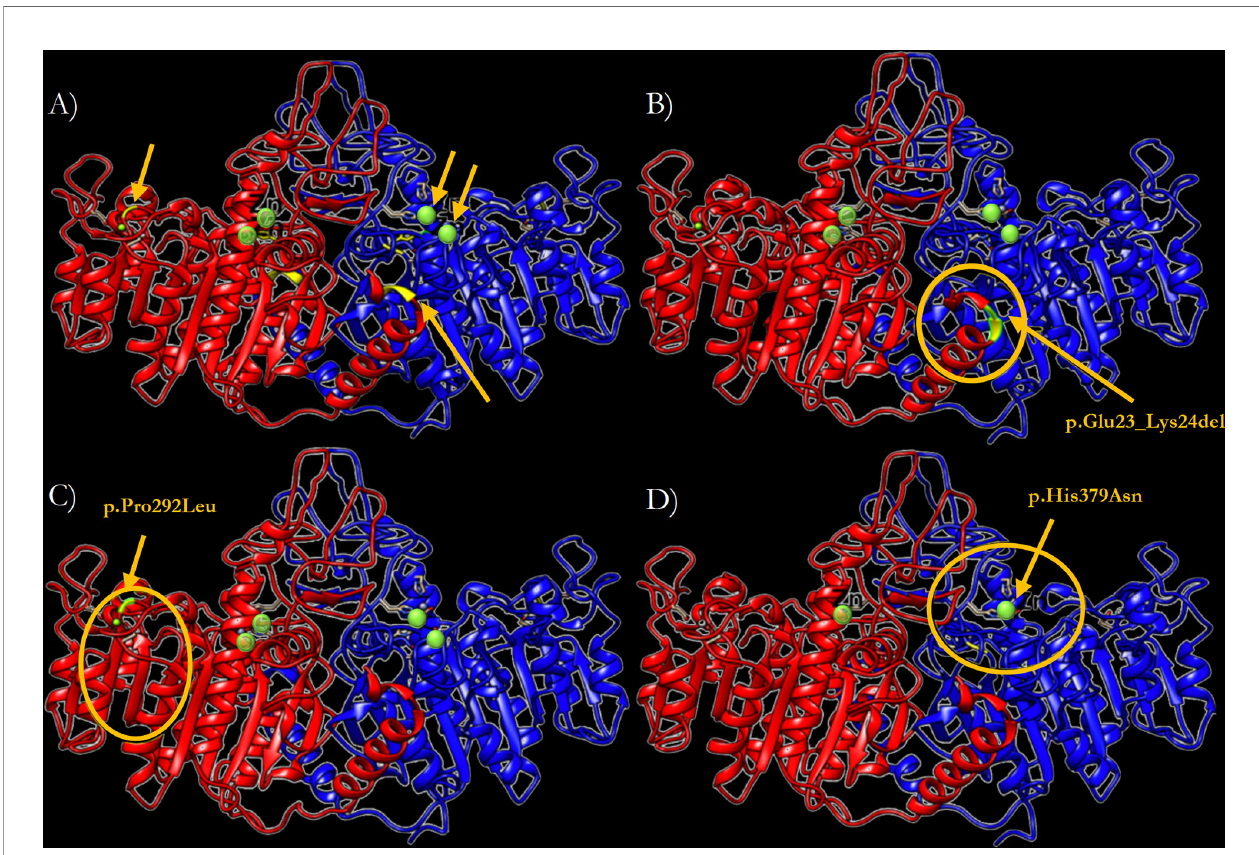
FIGURE 5 | Three-dimensional representation of the TNSALP protein in the form of ribbons. (A) TNSALP WT. Zn 2+ atoms bound to the corresponding Zn 2+ binding sites are highlighted in green. The arrows indicate the location of the different mutations identi fi ed in this study. (B) TNSALP with the genetic variant p.Del Glu23_Lys24. The deletion is marked in yellow and the major structural changes are highlighted with a yellow circle. (C) TNSALP with the genetic variant p.Pro292Leu. The amino acid substitution is marked in yellow and the major structural changes are highlighted with a yellow circle. (D) TNSALP with the genetic variant p.His379Asn. The loss of 2 of the 4 Zn 2+ binding sites in the dimeric protein is highlighted with a yellow circle in one of the protein